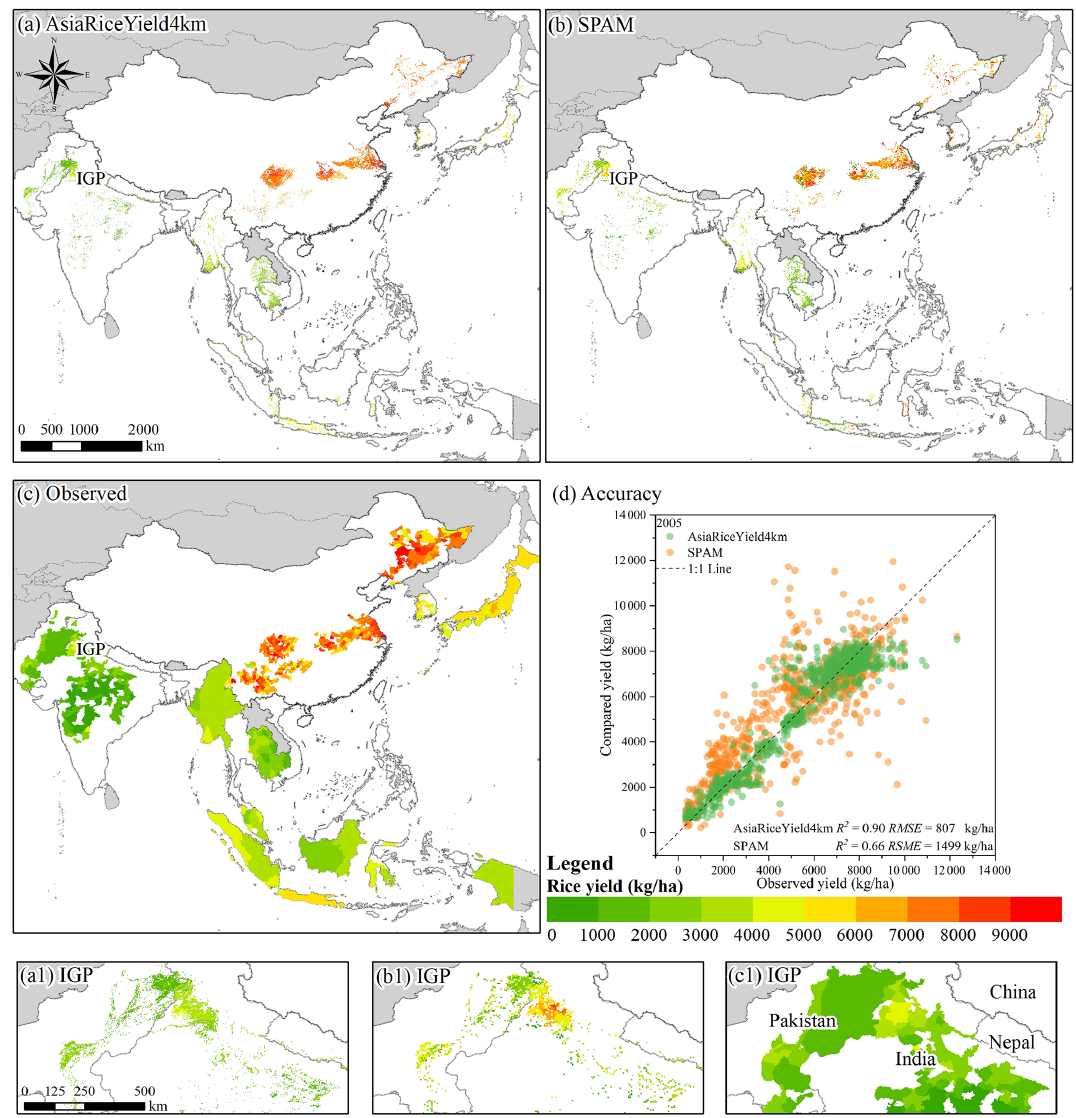
Figure 6. Yield distribution of (a) AsiaRiceYield4km, (b) SPAM and (c) observed yields in 2005 as well as (d) quantitative comparisons with the observed yields in 2005. Panels (a1) to (c1) are the zoomed in views of the IGP in Pakistan and India for (a1) AsiaRiceYield4km, (b1) SPAM and (c1) the observed